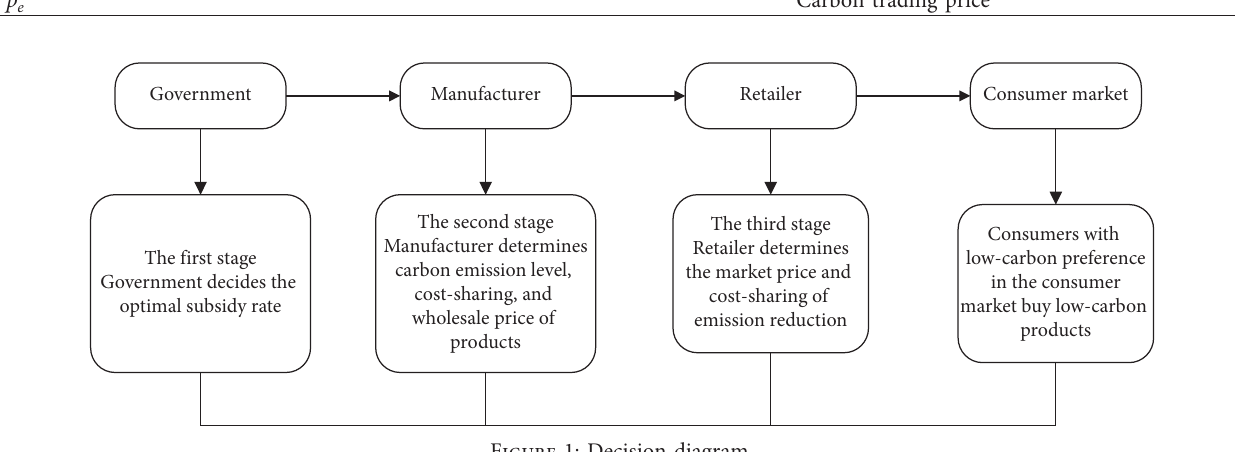
Figure 1: Decision